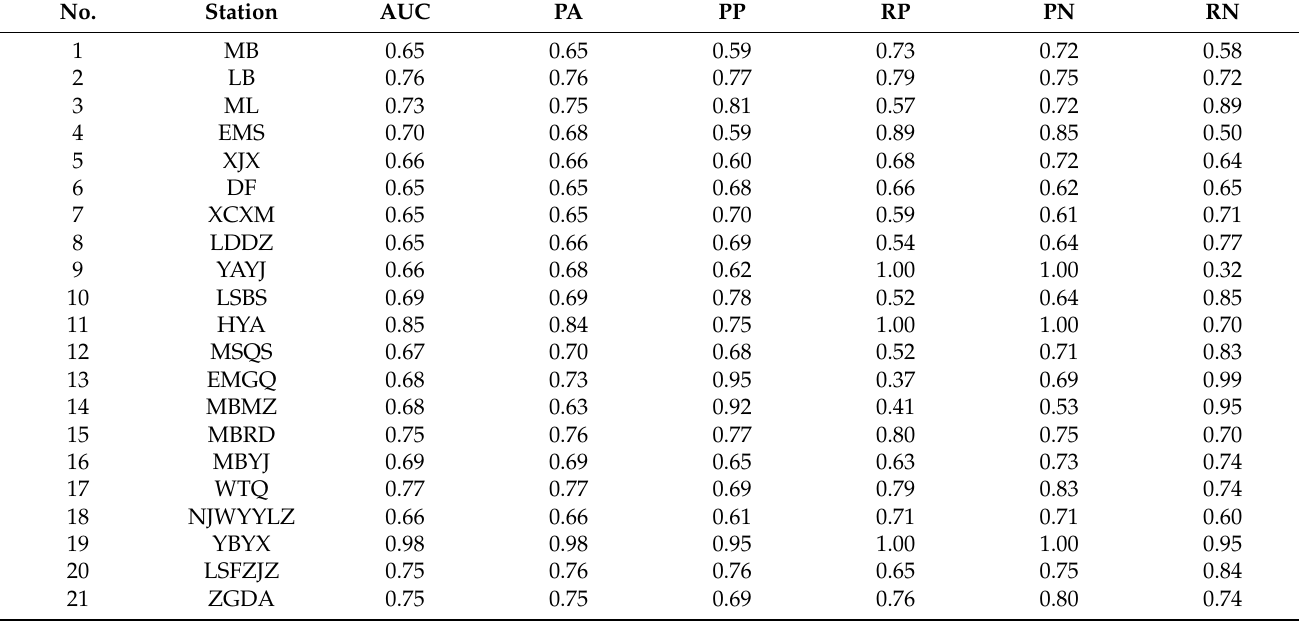
Table A3. Prediction results of LSTM on